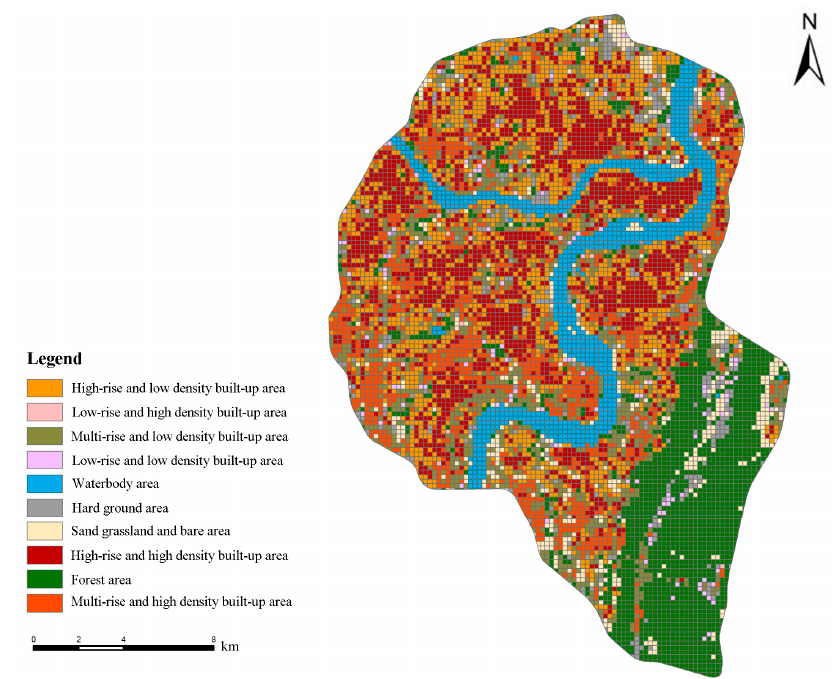
Figure 9. Spatial distribution of different street types.